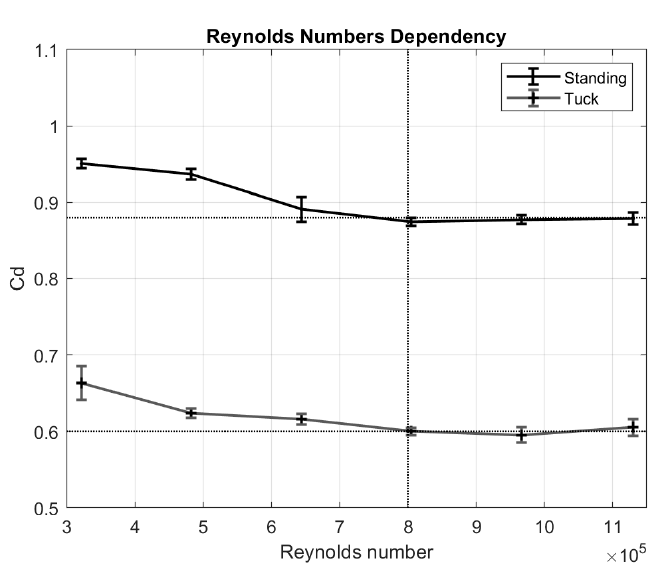
Figure 4. Uncorrected results of drag coefficient with respect to Reynolds number from the Standing and Tuck position measured PoliMi. The measured points correspond to measurements at every 5 m/s from 10 to 35 m/s. The error bars show the standard deviation with n =